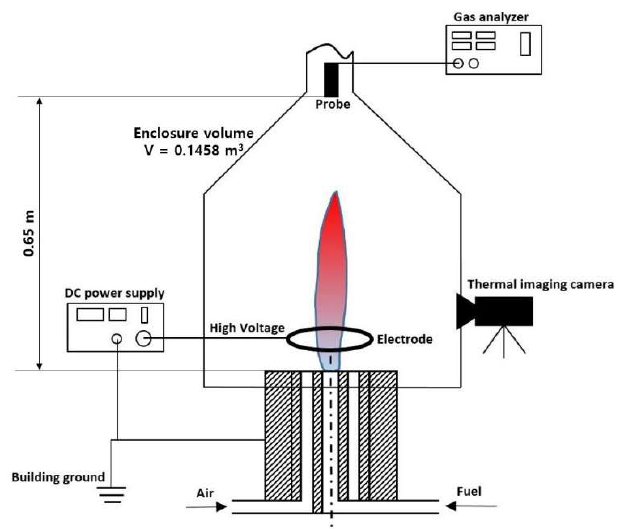
Figure 1. Experimental setup.